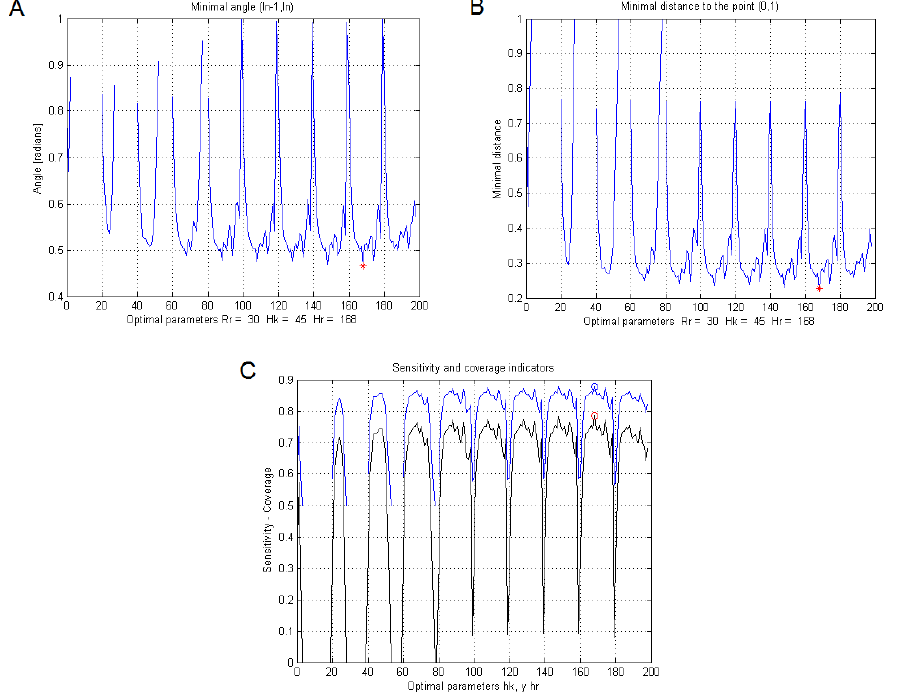
Figure 7. The optimal parameters for segmentation are obtained with the PST. This image shows the results obtained with the proposed method in each of the six sub-images in Figure 1.